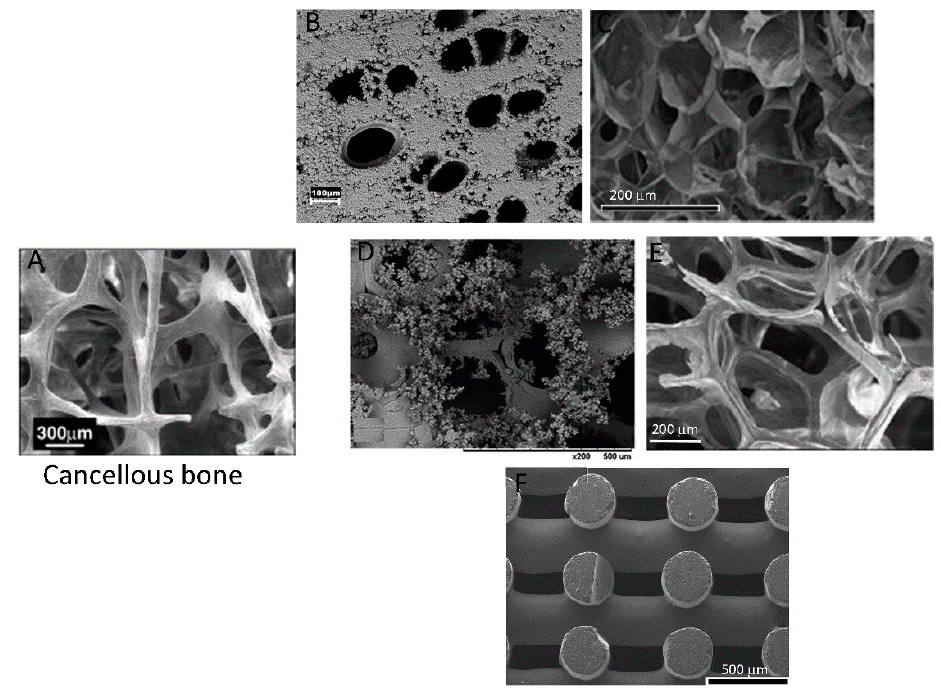
Figure 4. Scanning electron microscopy images of bone structure ( A, Reproduced with